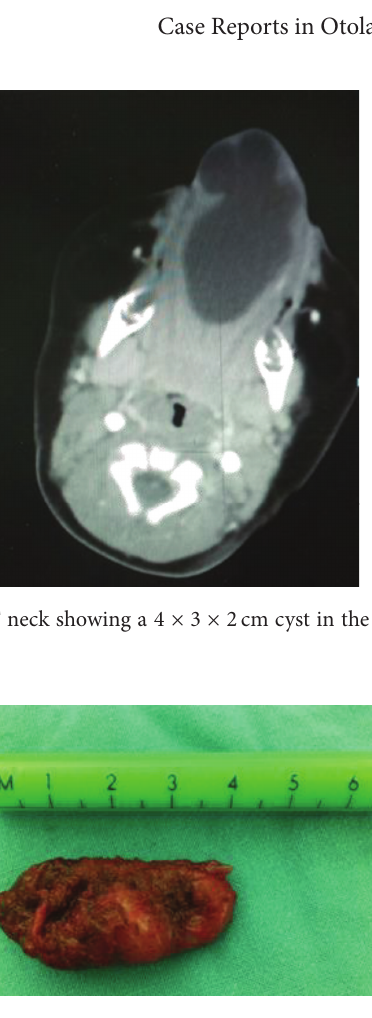
Figure 4: The cyst excised measures 4 ×